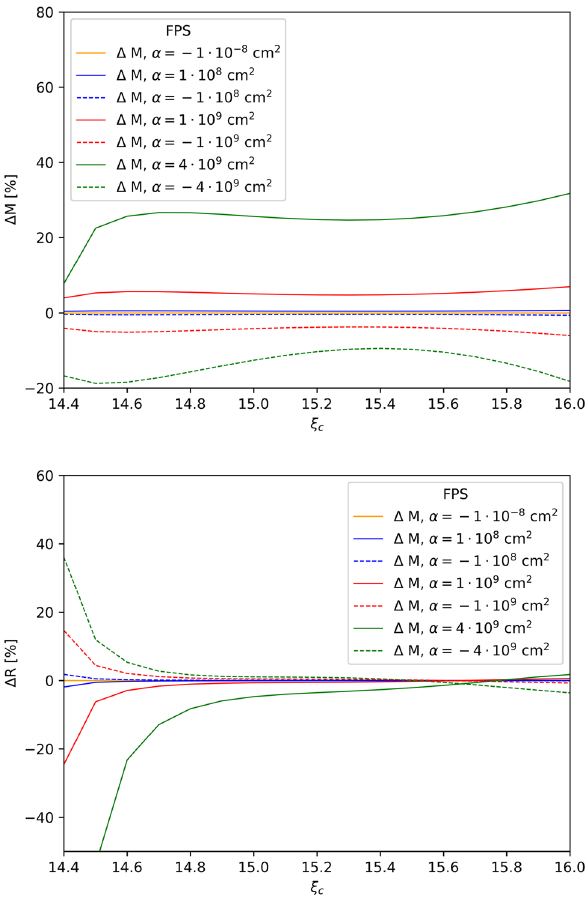
Fig. 6 Differencebetweenthemass(upperpanel)andtheradius(lower panel) obtained, given a central density value ξ , with f ( R , Q ) = R + α R 2 and GR, for the HS(DD2)